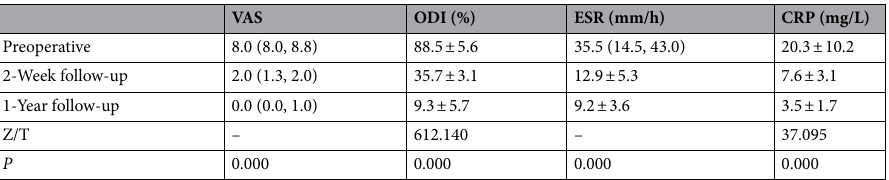
Table 2. Comparison of preoperative and postoperative VAS, ODI, ESR, and CRP. VAS: preoperative vs. 2-week follow-up: Z = − 3.551, P = 0.000; preoperative vs. 1-year follow-up: Z = − 3.543, P = 0.000; 2-week follow-up vs. 1-year follow-up: Z = − 3.508, P = 0.000. ODI: preoperative vs. 2-week follow-up: T = 31.327, P = 0.000; preoperative vs. 1-year follow-up: T = 36.063, P = 0.000; 2-week follow-up vs. 1-year follow-up: T = 20.702, P = 0.000. ESR: preoperative vs. 2-week follow-up: Z = − 3.519, P = 0.000; preoperative vs. 1-year follow-up: Z = − 3.411, P = 0.001; 2-week follow-up vs. 1-year follow-up: t = 2.577, P = 0.021. CRP: